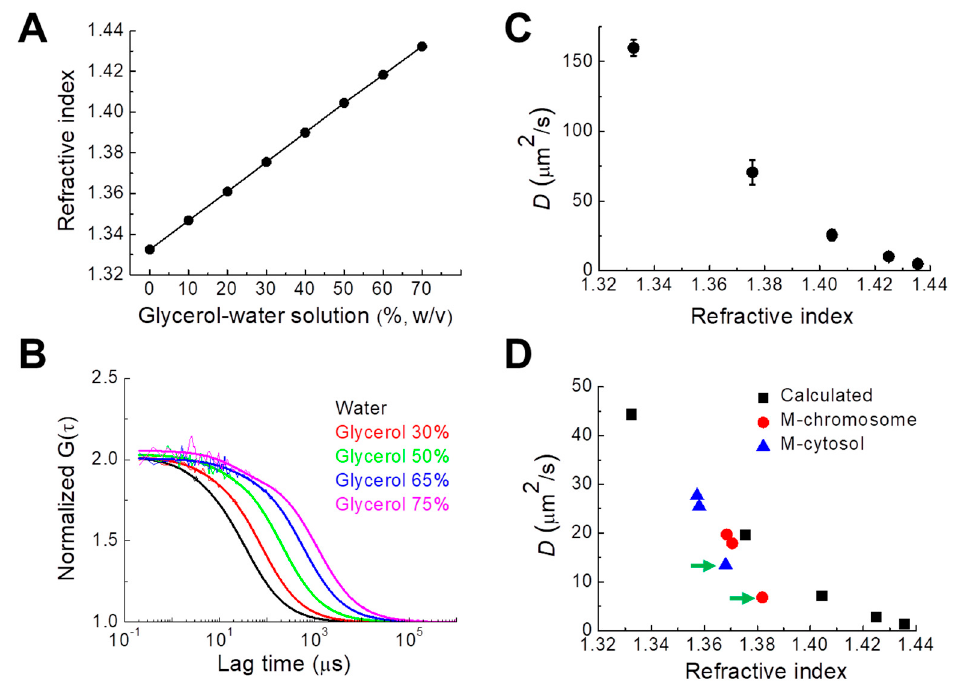
Figure 4. Experimental determination of the relationship between the D values of rhodamine 6G and the RIs of the medium. ( A ) Measured RI values of water and various glycerol–water solutions of known concentration at 25 ◦ C. Note that the standard error was smaller than 0.00005 and is not shown in the plot. ( B ) Measured FAF curves of rhodamine 6G in water and four di ff erent glycerol–water solutions of known concentration. For comparison of mobilities, all functions were normalized to the same amplitude, G (0) = 2. Bold solid lines indicate fitting of one-component di ff usion model to the results. The fitting results were used for evaluating D value. ( C ) Relationship between the RI values of the solutions obtained from A and the D values of rhodamine 6G in glycerol–water solutions obtained from B . ( D ) Plot of the calculated D values of mGFP in glycerol–water solutions with known viscosity vs. RI values (black) measured at 25 ◦ C. Measured D values of mGFP in mitotic chromosomes (red) and cytosol (blue) of DM cell under hypotonic, DMEM, and hypertonic culture conditions are shown. The RI values of mitotic cytosol and chromosomes measured at 37 ◦ C were compared with the values at 25 ◦ C, according to the linear relation between RI and density values at two di ff erent temperatures (Table 1, Figure